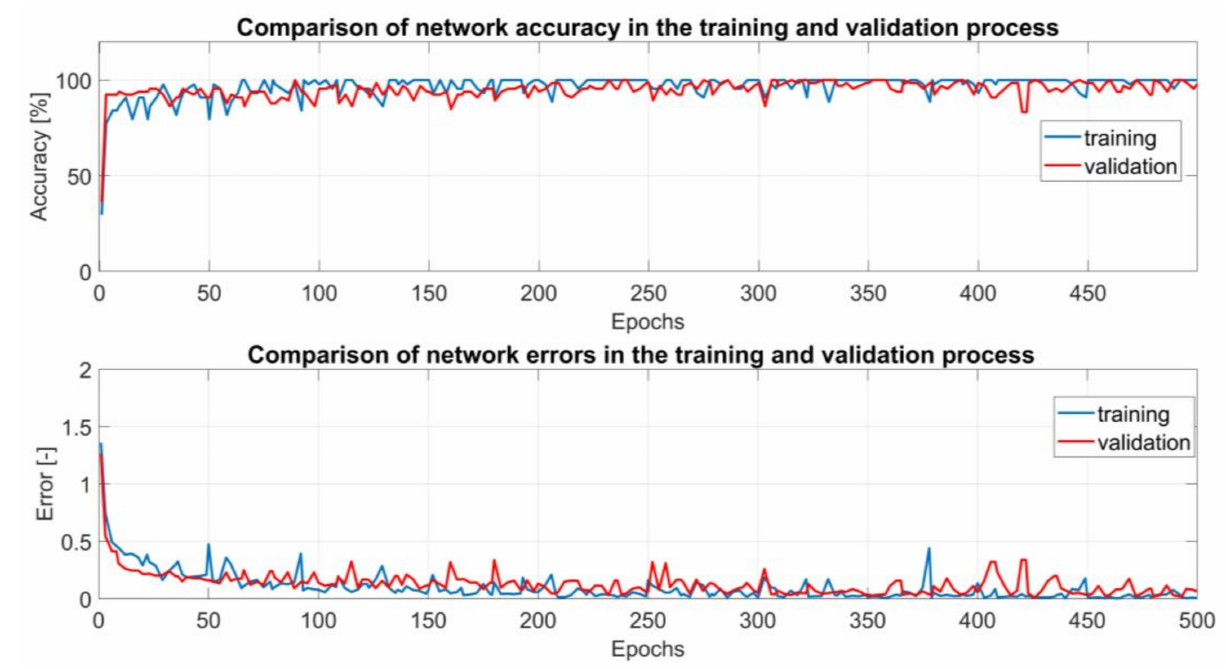
Figure 9. Curves of changes in accuracy and network error during training and validation process for the features of the received pressure signals.